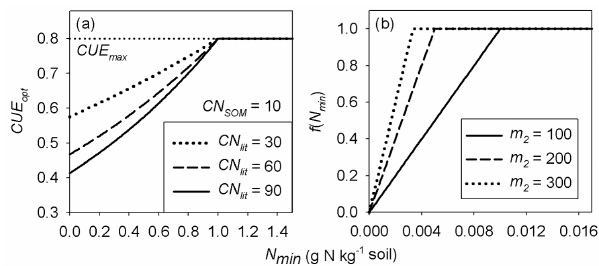
Figure 2. Schematic plot of (a) the optimal carbon use efficiency (CUE opt ) as a function of soil mineral nitrogen for different litter C:N ratios (from Eq. 2) in the main text (with m 1 = 0 . 3, n 1 = 1 . 0) and (b) the N limitation function f ( N min ) applied to litter decom- position rates (from Eq. 5) in the main text. CN lit and CN SOM are the C:N ratios of the litter and SOM pools, respectively. CUE max = 0 . 8 is the maximum CUE under optimal nutrient condition (C limi- tation only). m 1 and n 1 are the parameters of Eq. (3) and m 2 is the parameter of Eq.